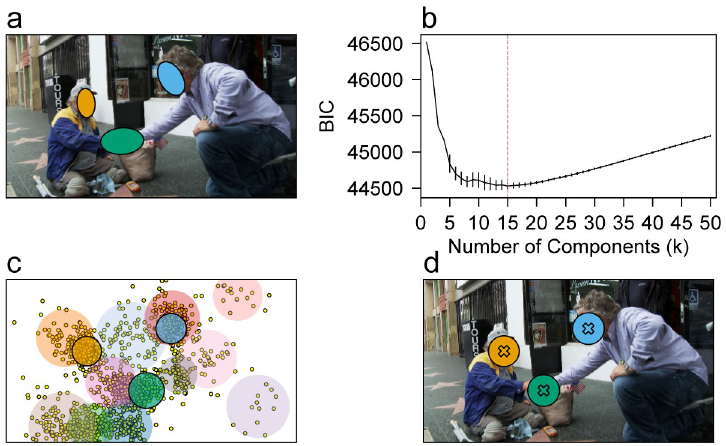
Fig 2. Example of AOI/POI definitions and selected mixture components. a) AOI definitions from the original study (ellipses) are illustrated in an exemplar image. b) The average BIC for GMMs fitted with different numbers of components ( k ). The error bar denotes the standard deviation of BIC across 50 different fitted GMMs. The reddish- purple dotted line denotes the number of component with the least average BIC. c) An example of visualization of Gaussian components of the fitted GMM with the selected number of components that had the lowest BIC. The yellow dots represent the offset- and drift-corrected locations of all fixations across all participants to the exemplar image. The components are visualized as semi-transparent colored circles with means at the means of the components and radii of 2 σ . The components selected to match the AOI have black boundary lines. d) An example of selected mixture components that correspond to the AOIs defined in the original study. The means of selected mixture components (Xs) were used as the POI.